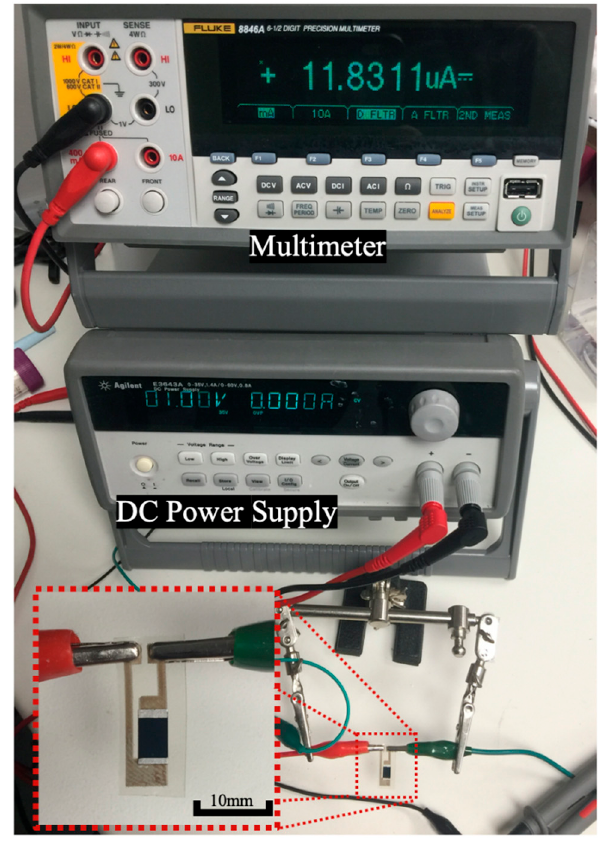
Figure 3. Photographic image of the experiment set-up for measuring the I-V curves of the paper